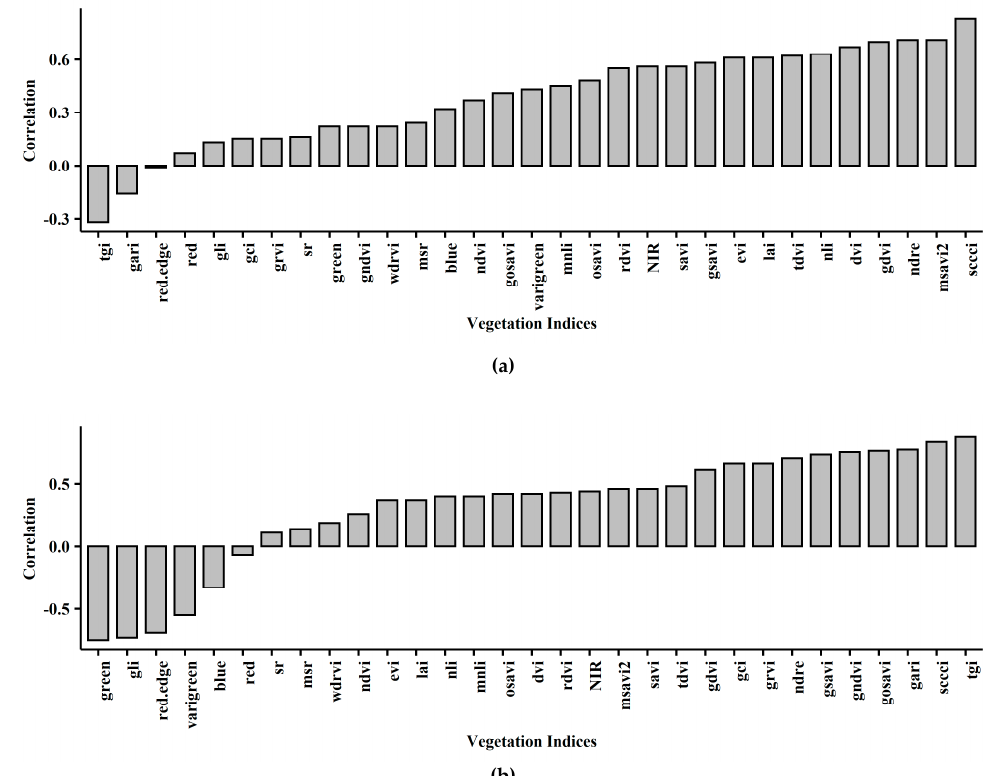
Figure 6. Yield density plot (solid line) and corresponding normal distribution (dash line).